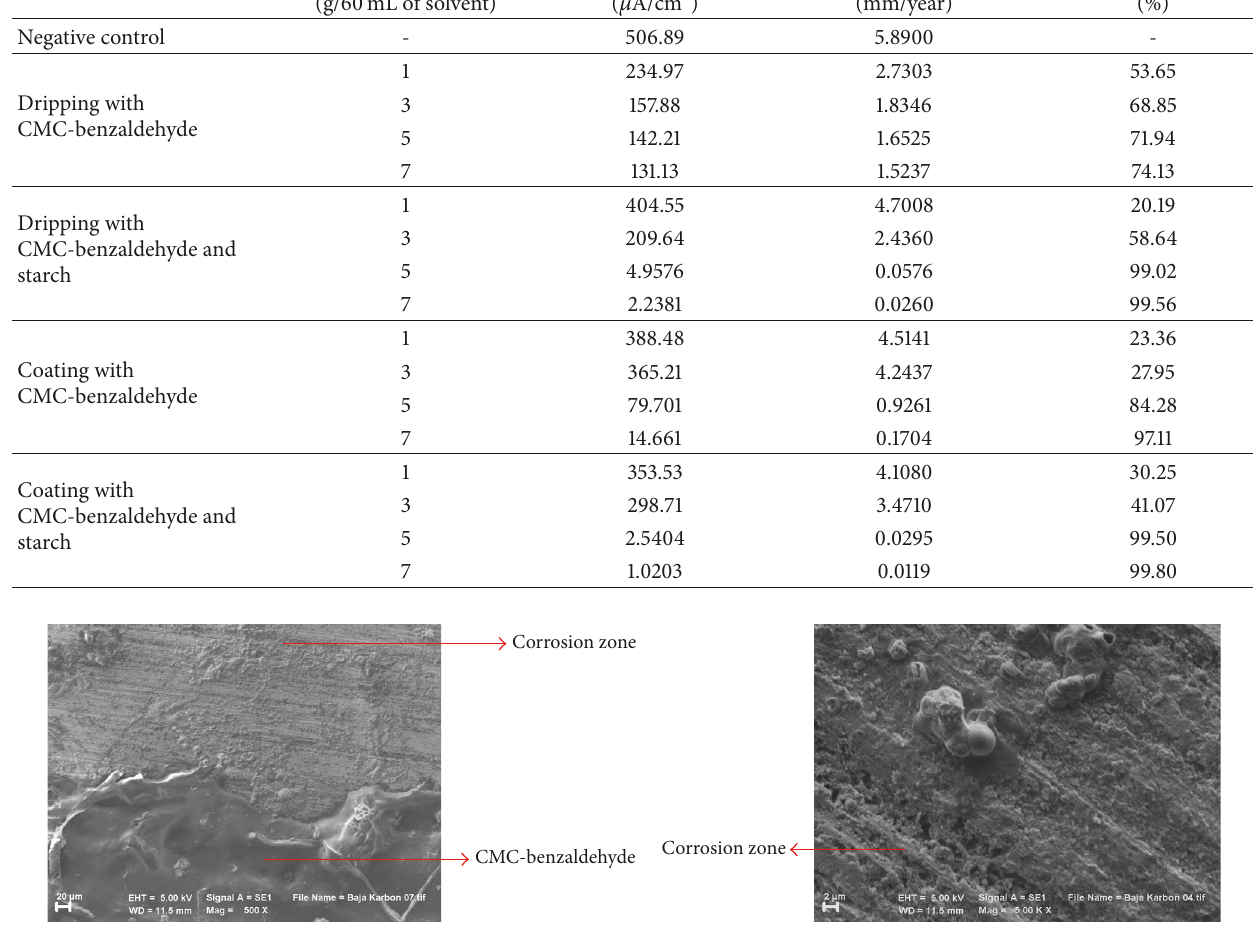
Figure 9: The analysis results of surface morphology using SEM for steel surfaces that have been added using (a) CMC-benzaldehyde with starch and (b) CMC-benzaldehyde without starch after potentiostatic polarization (coating method, concentration of 7 g/60